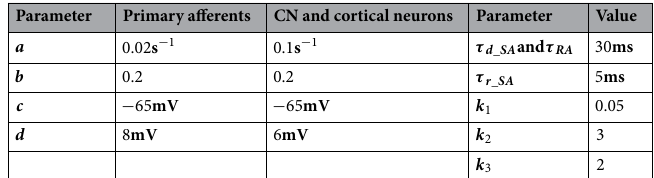
Table 3. Parameter values of the spiking model of SA-I and RA-I used in the simulations. Izhikevich neuron model parameters (a, b, c, d) of primary afferents are taken from 34 .